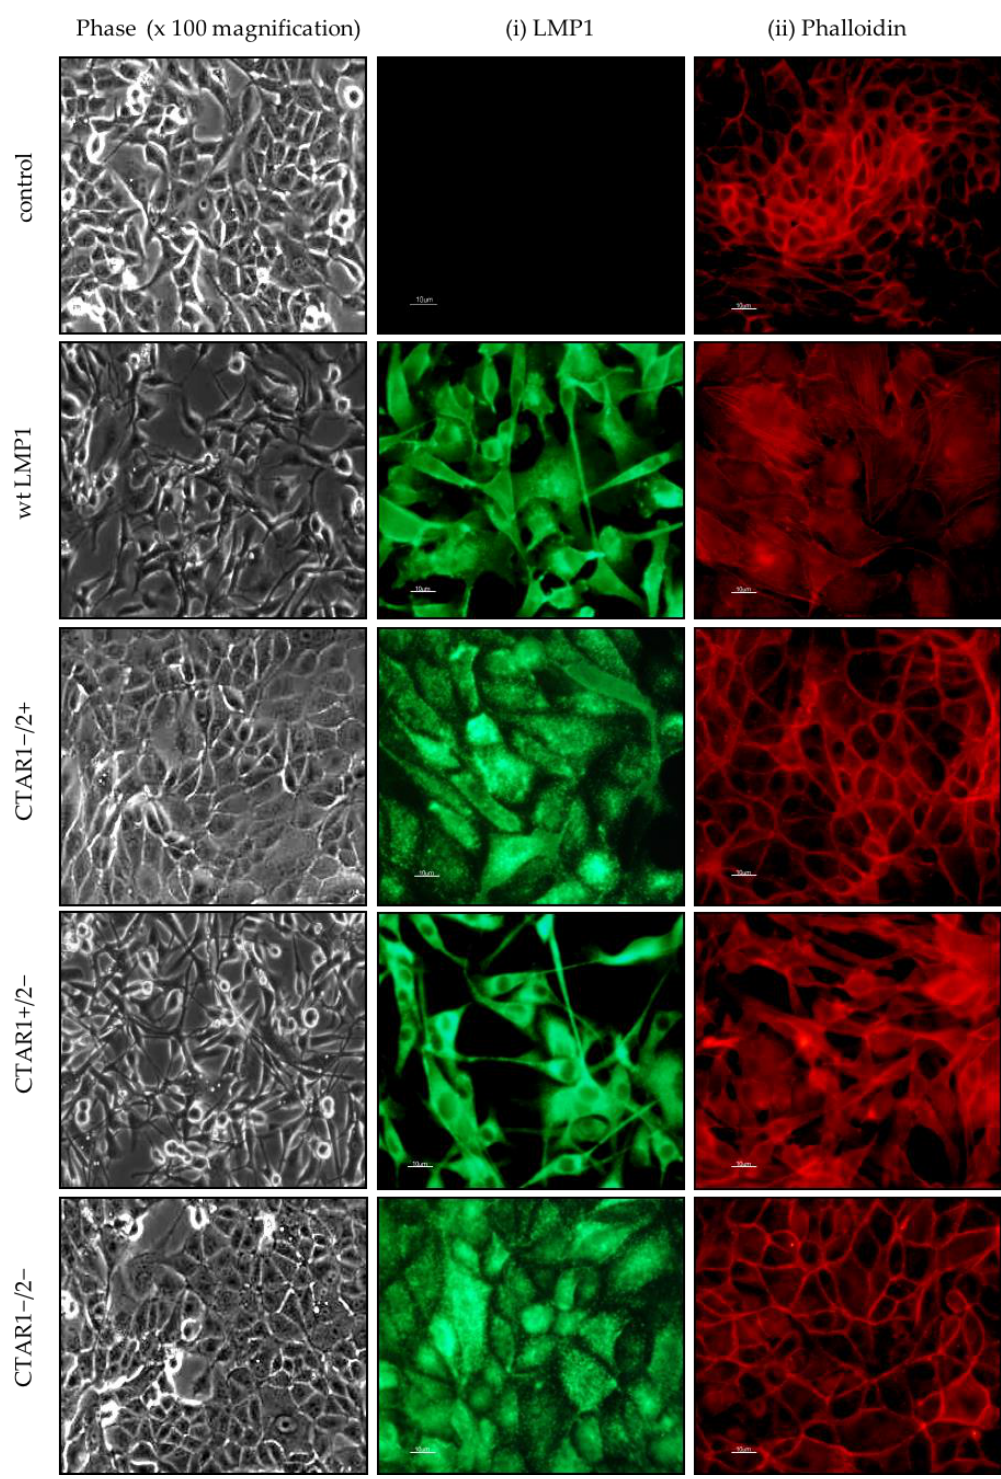
Figure 1. Stable LMP1 expression alters cell morphology. Phase contrast images of Madin Darby Canine Kidney (MDCK) epithelial cells stably expressing the neomycin control, wildtype LMP1 (wt LMP1), CTAR1−/2+ LMP1, CTAR1+/2− LMP1 and CTAR1−/2− LMP1 mutants were captured on a Zeiss digital microscope at 100× magnification. (i) Immunofluorescence staining using an LMP1-specific monoclonal antibody, CS2, confirmed ubiquitous expression of LMP1 in the wildtype and CTAR1/2 domain mutants; (ii) Actin stress fibre formation was confirmed in the wildtype and CTAR1+/2− mutant LMP1-expressing cells only, as visualised using TRITC-conjugated Phalloidin Ig. Bar = 10 μ m.